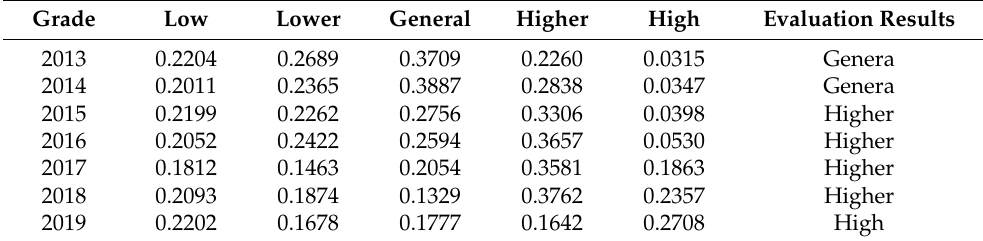
Table 10. Evaluation Results of Logistics Decarbonization Development in Beijing from 2013–2019.